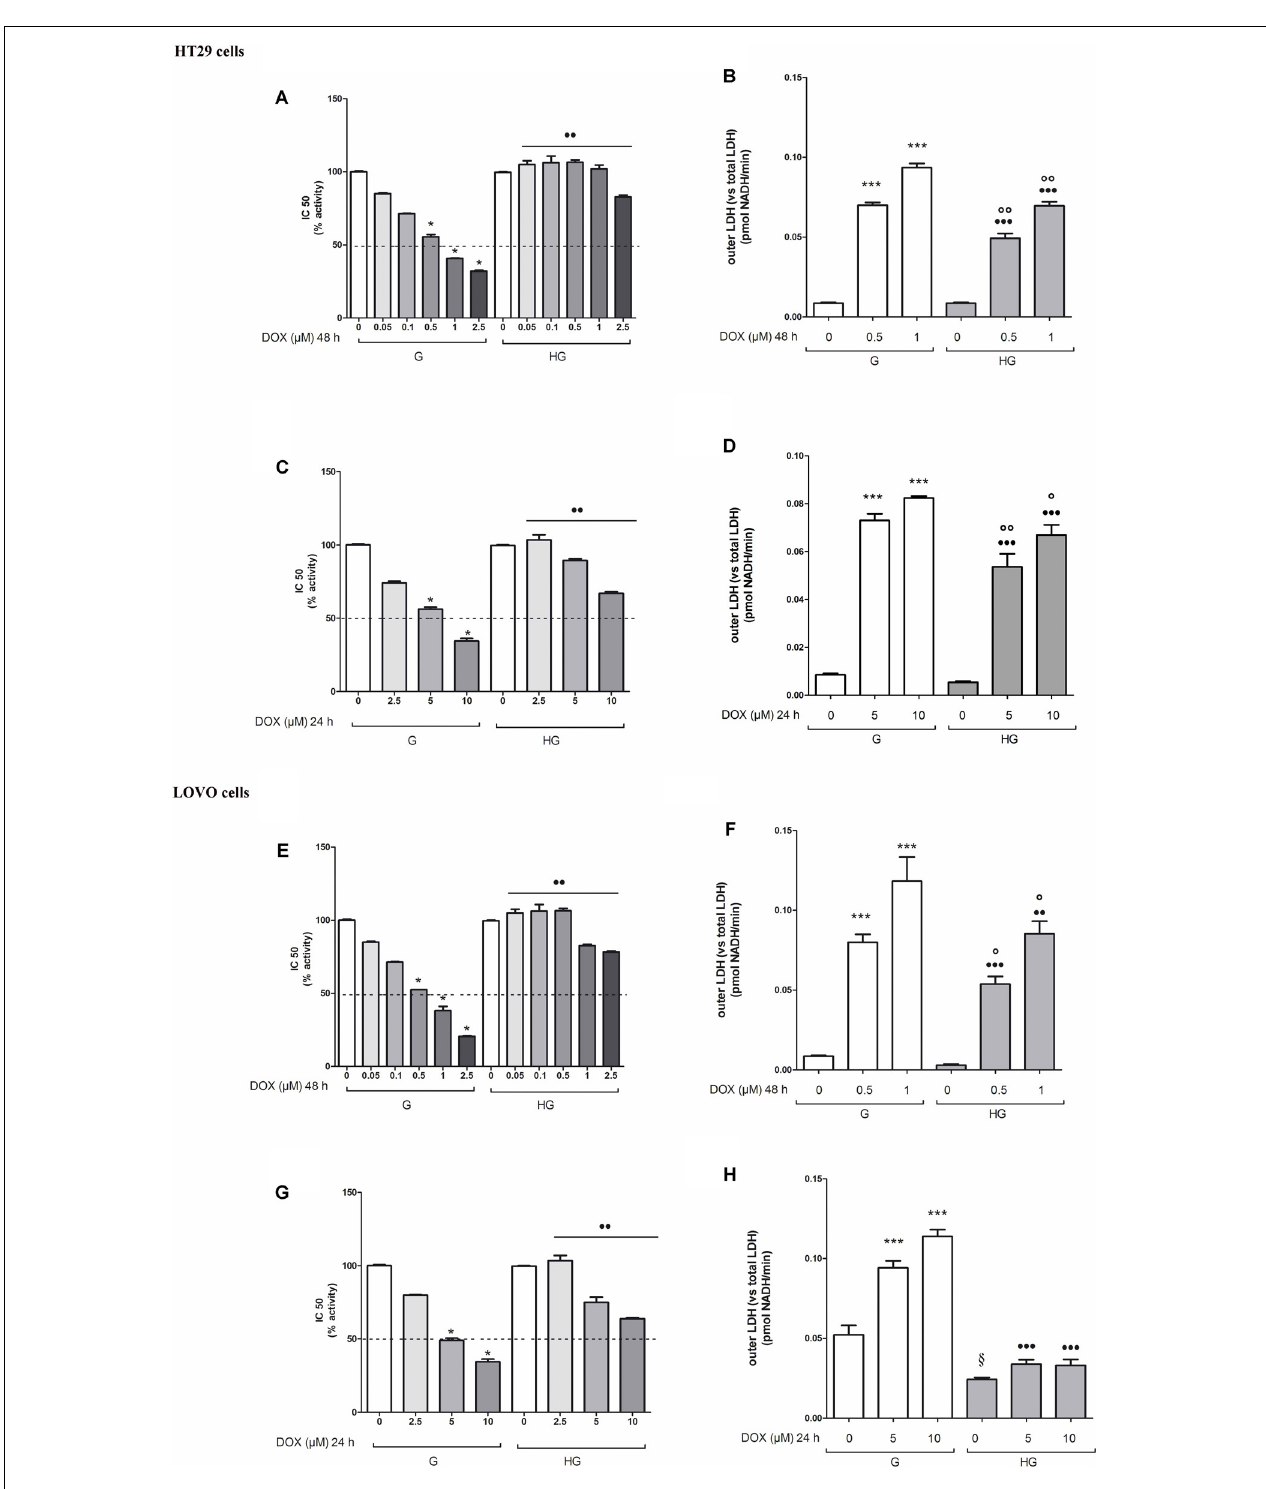
FIGURE 1 | Effect of normal glucose (G) and high glucose (HG) on cell proliferation and on LDH release from cells in the supernatant in absence or presence of doxorubicin (DOX) in human colon cancer (HT29 and LOVO) cells. Cells were cultured for ≥ 7 days in the presence of G and HG, then subjected to the following investigations. (A) Cells were left untreated or incubated for 48 h in the presence of different concentrations (0.05 µ M, 0.1 µ M, 0.5 µ M, 1 µ M, 2.5 µ M) of DOX (A,E) or 24 h in the presence of different concentrations (2.5 µ M, 5 µ M, 10 µ M) of DOX (C,G) . Samples were then stained in quadruplicate with the neutral red solution ( n = 4) to assess cell viability. IC50 was calculated as the concentration of DOX that kills 50% (dotted line) of cells. ∗ p < 0.01 0.5, 1, 2.5, 5, and 10 µ M DOX in